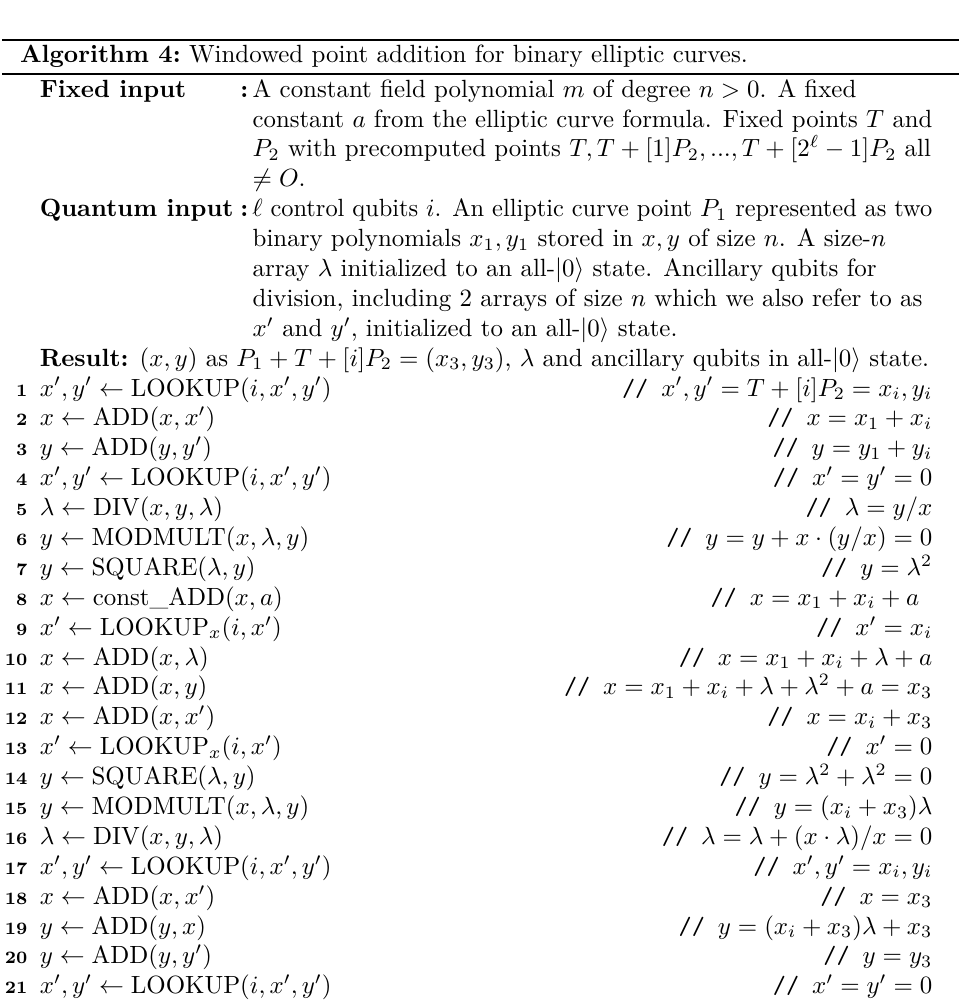
Algorithm 4: Windowed point addition for binary elliptic curves.